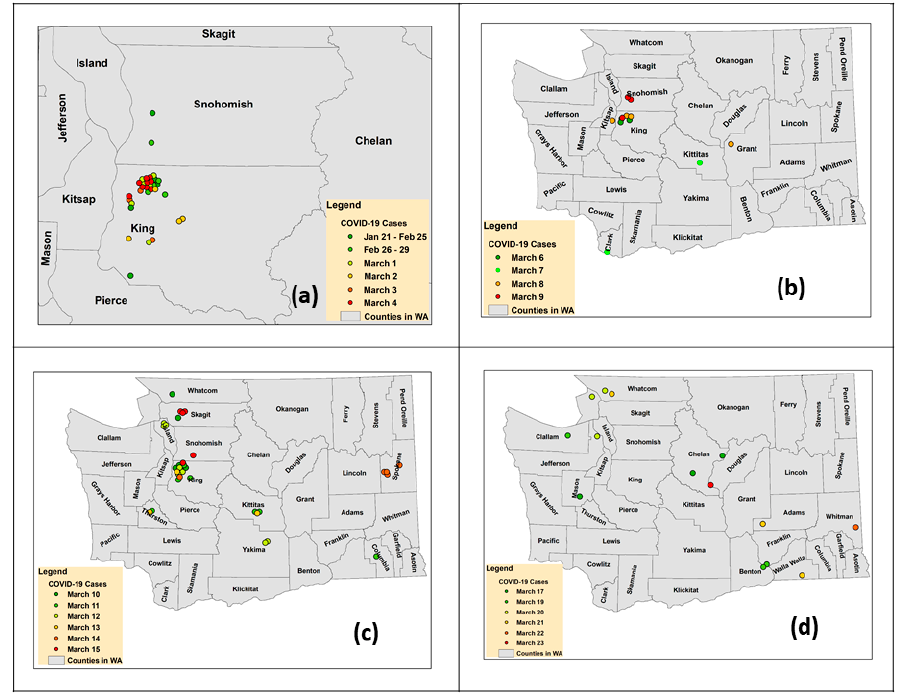
Figure 6. Proxy locations of all COVID-19 cases in WA: ( a ) 21 January to 4 March; ( b ) 6 March to 9 March ( c ) 10 March to 15 March; ( d ) 17 March to 23 March.